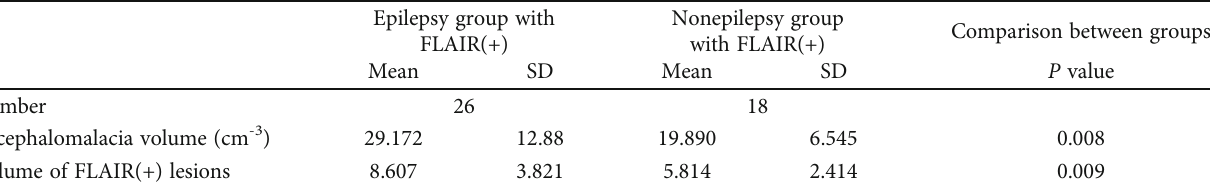
Table 2: Volume comparison of 26 FLAIR-positive patients from the epilepsy group and 18 FLAIR-positive patients from the nonepilepsy